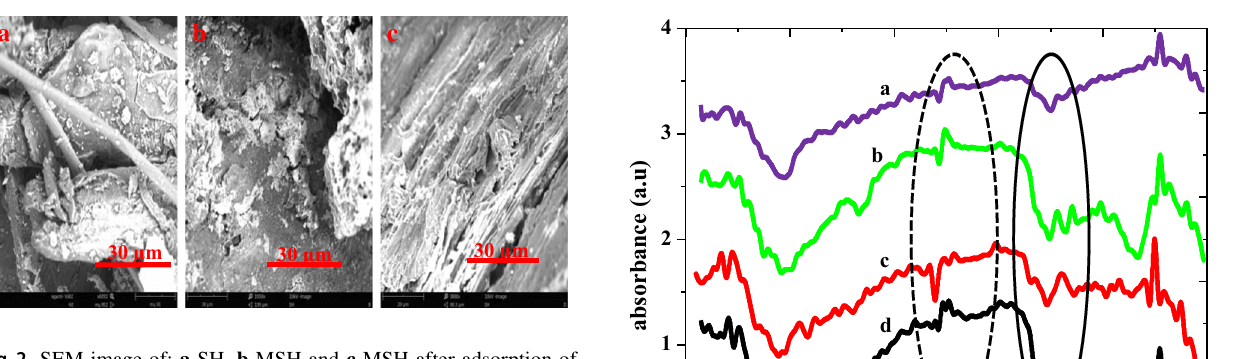
Fig. 2 SEM image of: a SH, b MSH and c MSH after adsorption of dyes